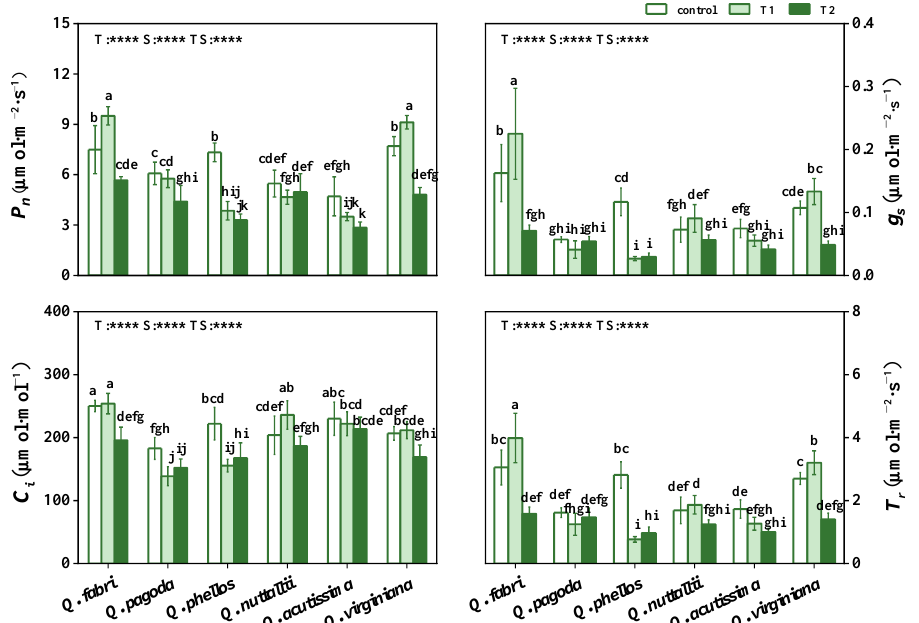
Figure 1. Photosynthetic rate ( P n , µ mol.m − 2 s − 1 ), stomatal conductance ( gs , mol H 2 O m − 2 s − 1 ), intercellular CO 2 concentration ( Ci , µ mol CO 2 mol air − 1 ), and transpiration rate ( Tr , mmol H 2 O m − 2 s − 1 ) in fresh leaves of six Quercus species cultivated in control, T1 (mixture of clean and polluted soil, 50%), and T2 (100% polluted soil) treatments that lasted for 150 d. Data represent the mean of three replicates ± SD (n = 3). p values of the two-way ANOVAs of soil treatments (T), Quercus species (S), and their interactions (T × S) were also shown. ns, not significant; **** p ≤ 0.0001. The different letters showed the significance at level of 0.05. Table 3. Photosynthetic pigments (mg ∙ g − 1 fresh weight) in leaves of six Quercus species cultivated in control, T1 (mixture of clean and polluted soil, 50%) and T2 (100% polluted soil) treatments for 150 d.